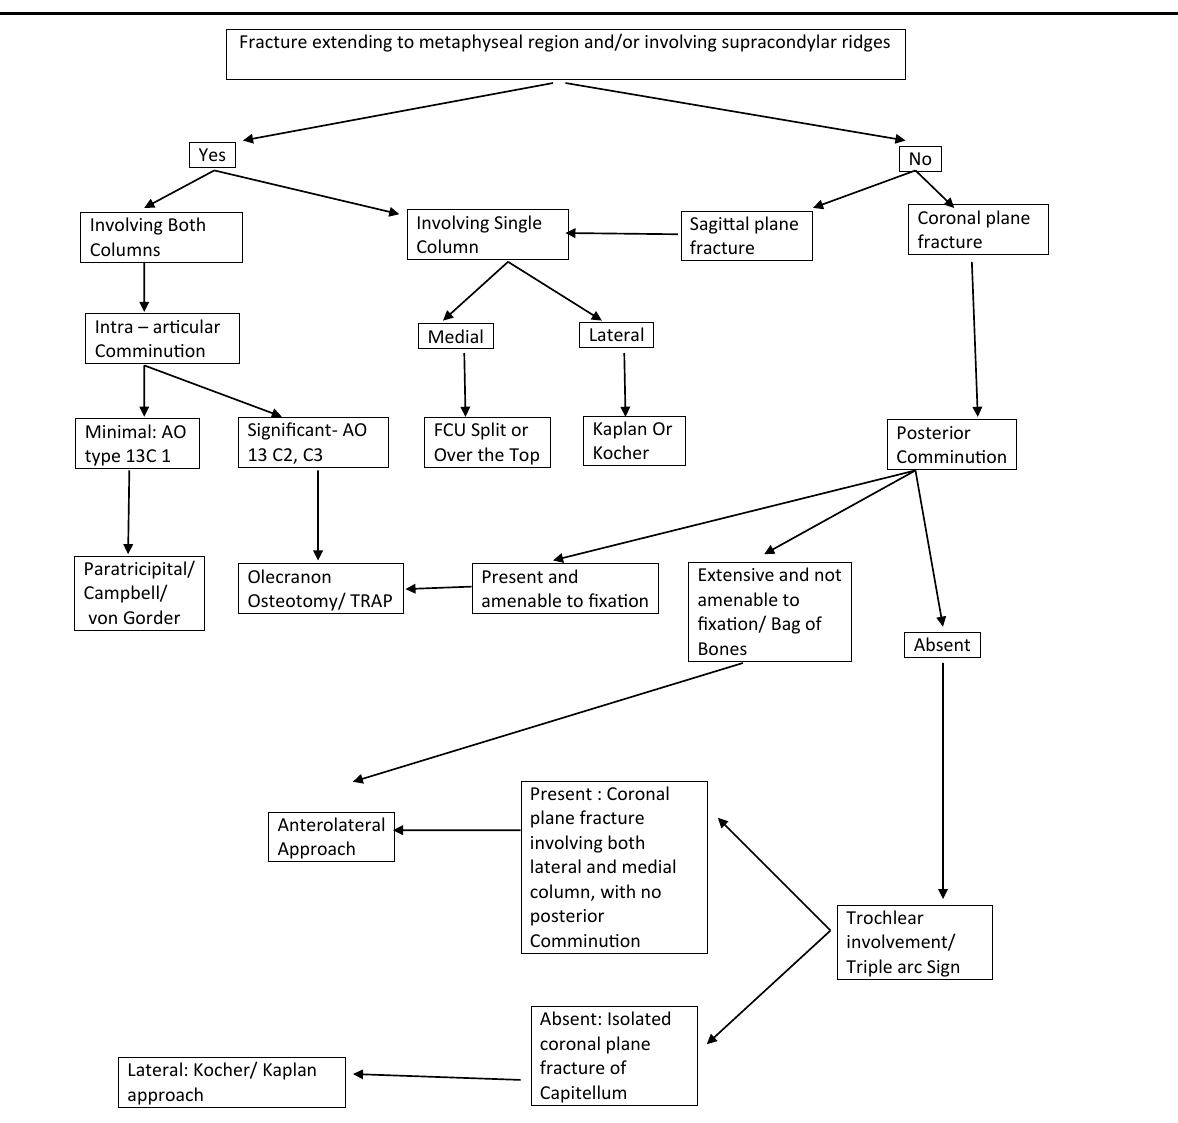
Table 2. Algorithm for guiding the selection of appropriate approach in Distal Humerus